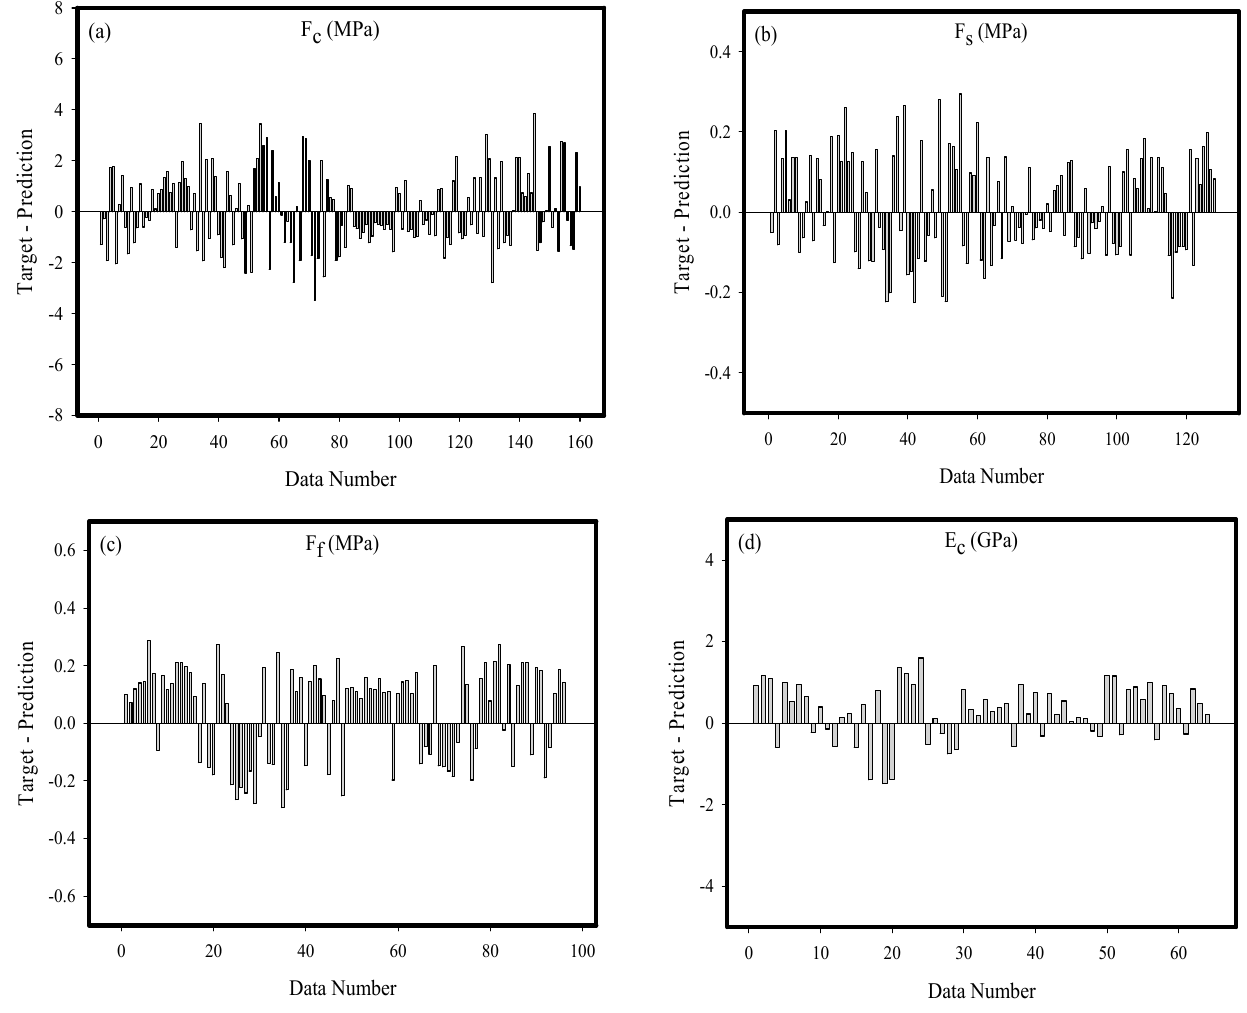
Figure 12. Various values considering data’s number. Figure 13 provides a clearer illustration of the agreement among the targeted values and ANN outputs. Every data point is illustrated to be close to the zero line error when looking at the locations of data points displayed for the Fc, Fs, Ff and Ec values. Addition- ally, it is noted that the data point fall within the 10 percent error limit. The MSE value for the created ANN model was calculated to be 6.45 × 10 − 2 , and the R value to be 0.99496. The created ANN model could be utilized in predicting Fc, Fs, Ff and Ec values having high accuracy based on the CR, NS, FA and p values, as can be observed from the perspective of all these